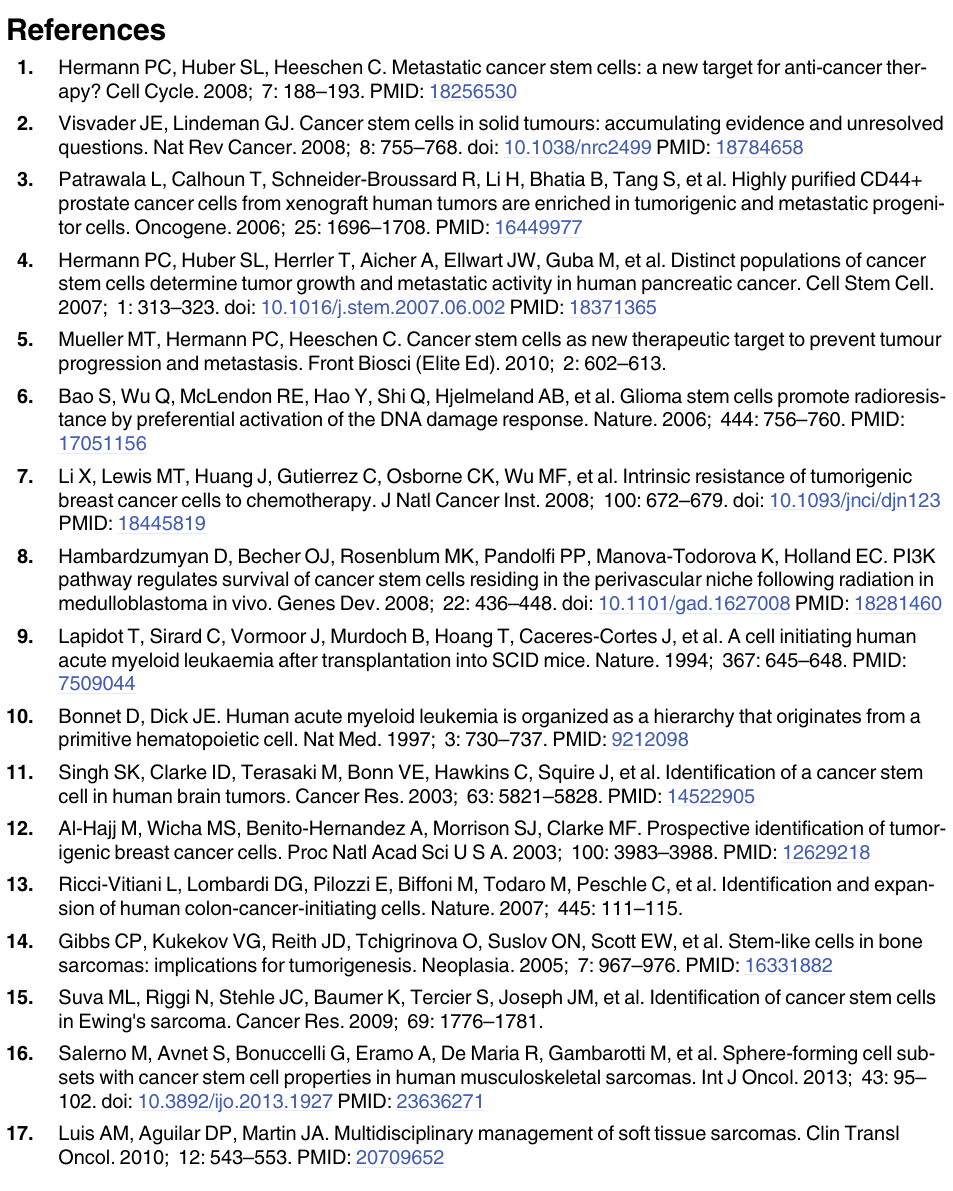
S1 Table. NormFinder, geNorm and CV ranking order of candidate reference genes in dif- ferent histotypes of sarcoma and